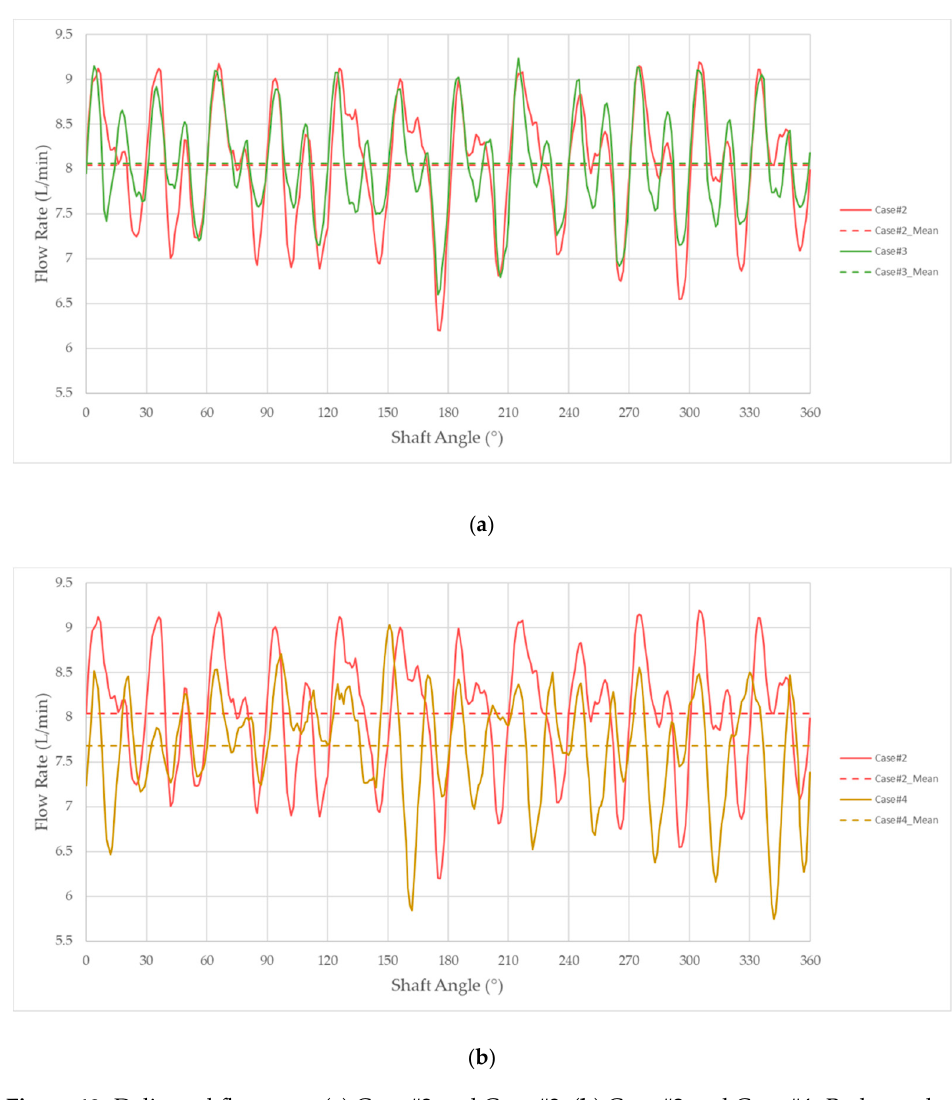
Figure 19. Delivered flow rate: ( a ) Case #2 and Case #3; ( b ) Case #2 and Case #4. Both graphs are illustrated with respect to the angular position of the pump driving shaft.